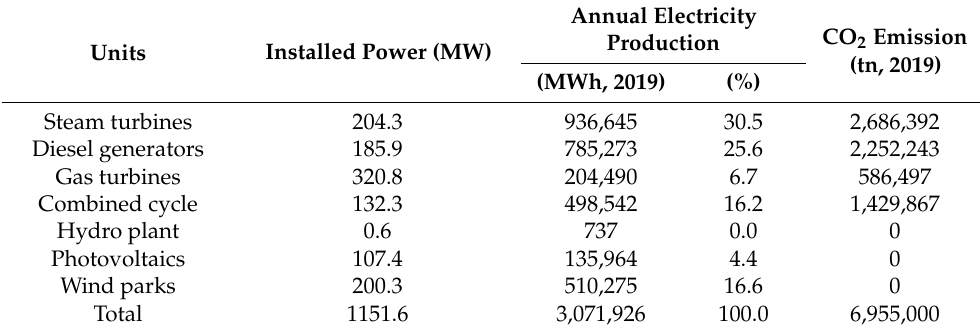
Table 2. Analysis of the electrical system and the annual electricity production in Crete in 2019.